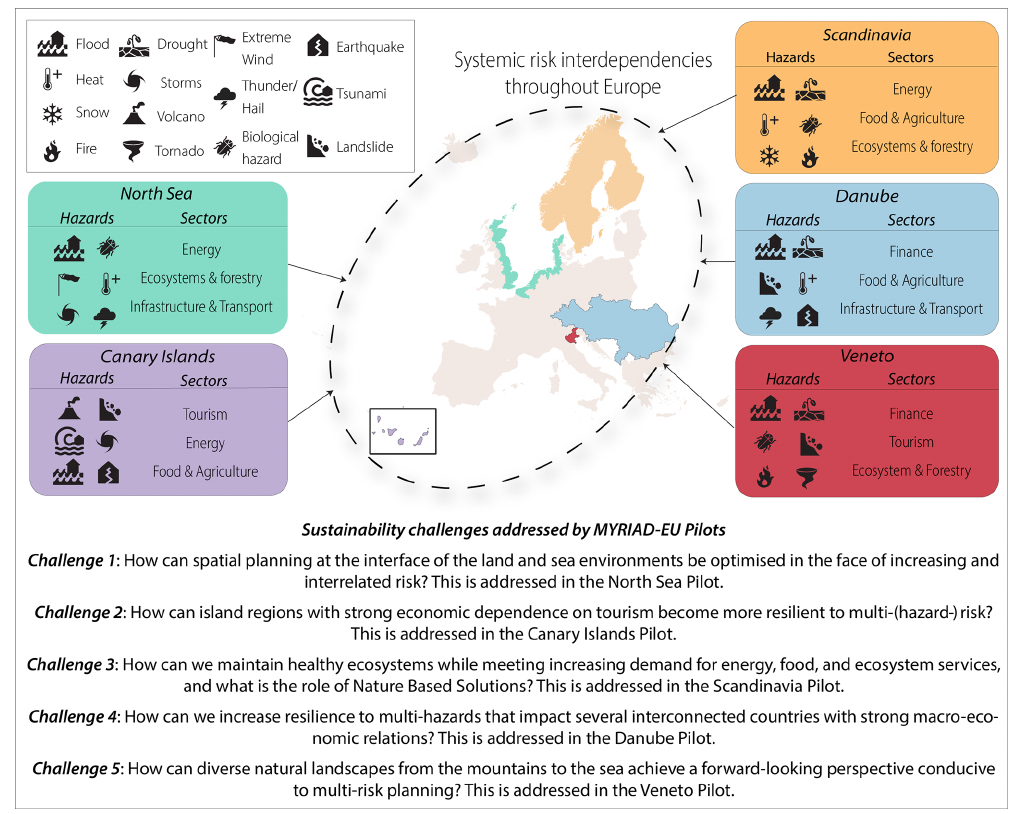
Figure 1. Overview of sustainability challenges to be addressed in the MYRIAD-EU